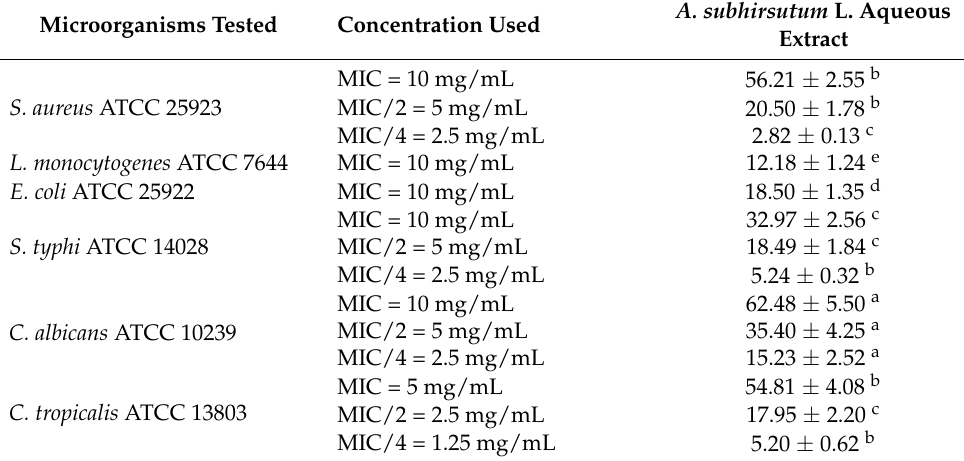
Table 6. Anti-biofilm results (inhibition %) of A. subhirsutum L. aqueous extract tested against Gram-positive and Gram-negative bacteria and yeast